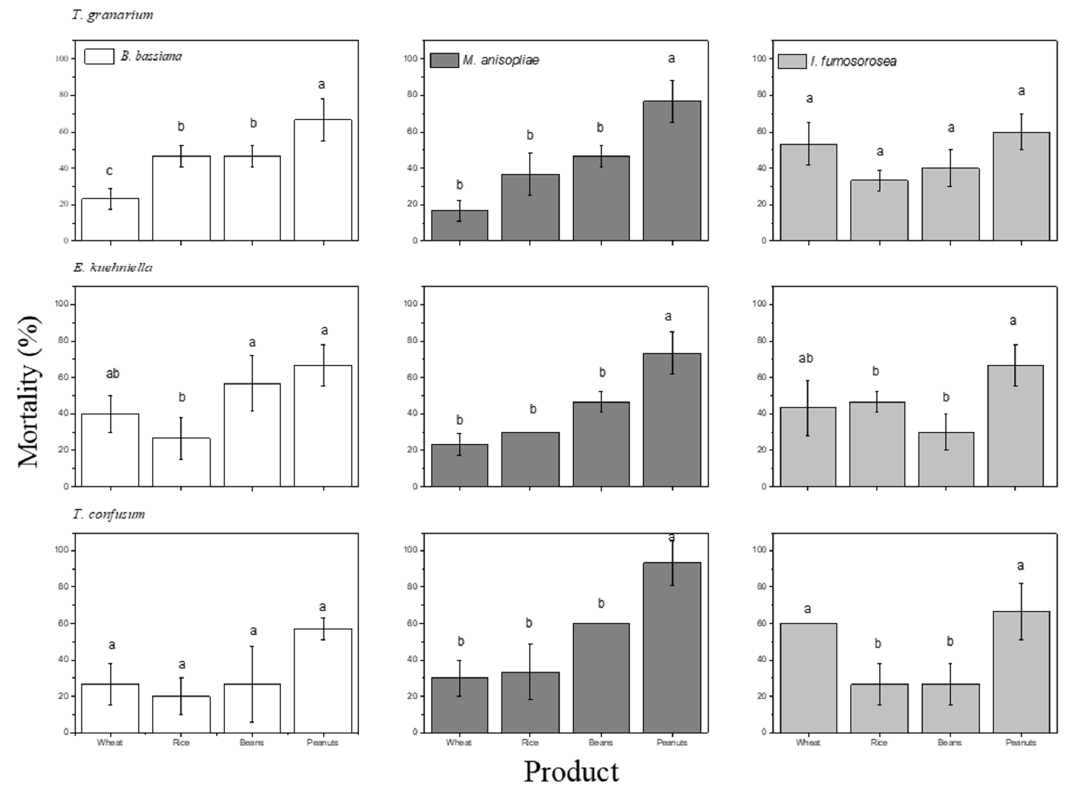
Figure 1. Mean larval mortality (% ± SD) of T. granarium , E. kuehniella and T. confusum exposed for 10 days to rice, beans, peanuts and wheat grains treated with 10 8 spores mL − 1 of B. bassiana (strain name: GBBSTTS), I. fumosorosea (strain name: RHZ4RAS) and M. anisopliae (strain name: Z3RAS). Mean ± sd values with the same letter within a column are not significantly different ( p <